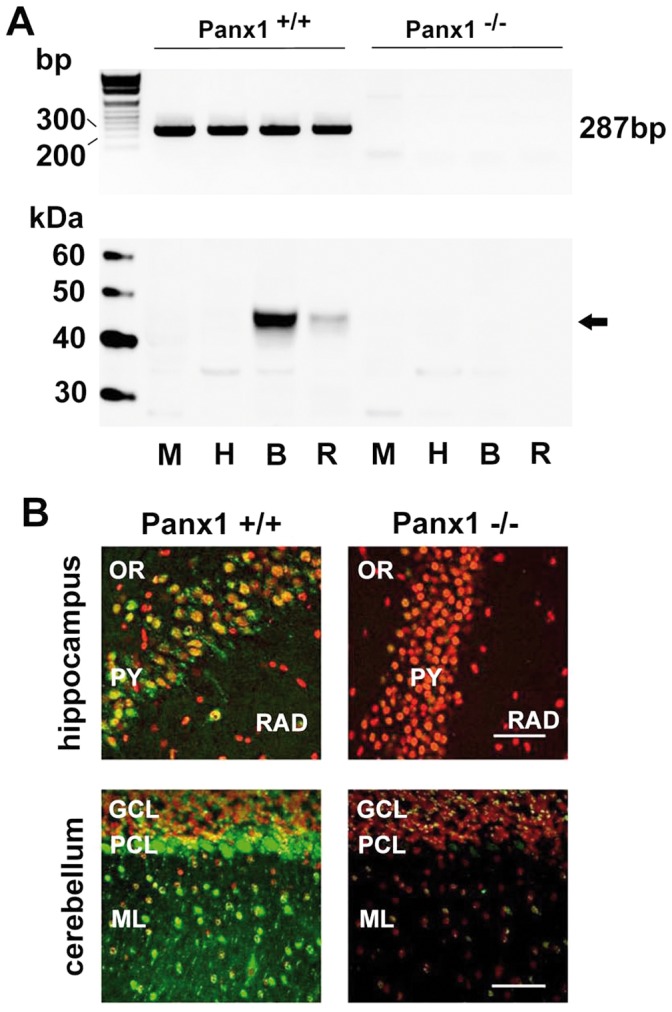
Characterization of Panx1−/− mice.a, RT-PCR and western blot analysis of 4 adult Panx1+/+ control and Panx1−/− animals. Note the lack of the 287 bp PCR amplicon representing the deleted exon4 in the Panx1 mRNA and the loss of the Panx1 protein in Panx1−/− mice. b, Immunohistochemistry demonstrating loss of Panx1 protein expression in CA1 region of the hippocampus and cerebellum. Abbreviations: M, muscle, H, heart, B, brain, R, retina, OR, stratum oriens, PY, stratum pyramidale, RAD, stratum radiatum, GCL, granular cell layer, PCL, Purkinje cell layer, ML, molecular layer. Scale bars: 100 µm.